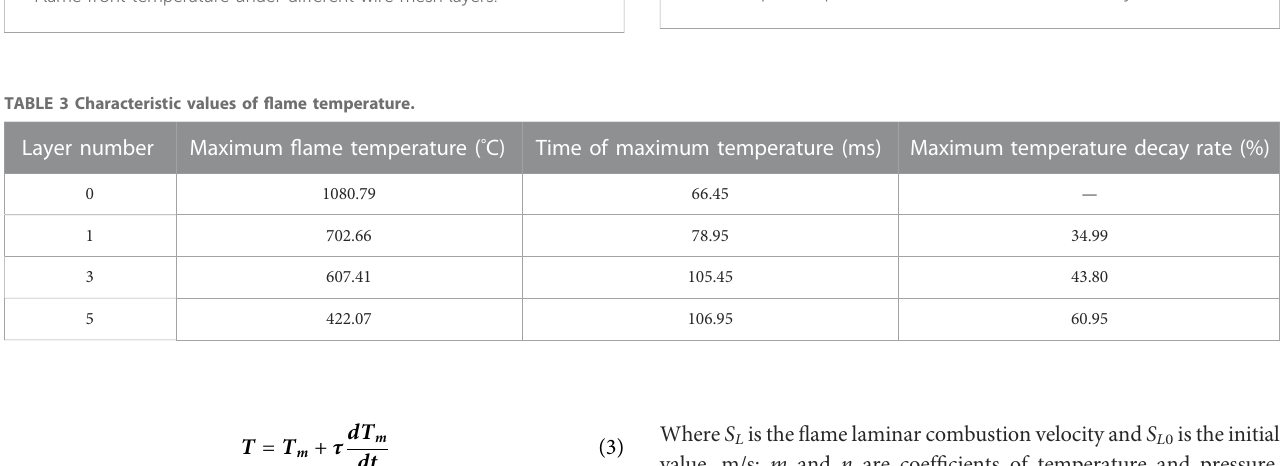
FIGURE 7 Flame front temperature under different wire mesh layers.